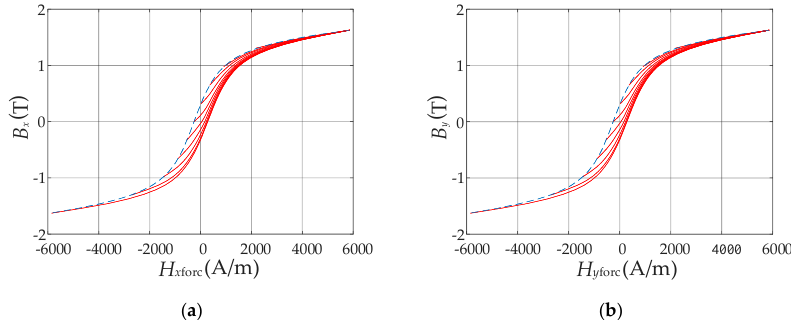
Figure 5. First-order reversal curves (FORCs) in two orthogonal directions: ( a ) In x direction; ( b ) In y direction.